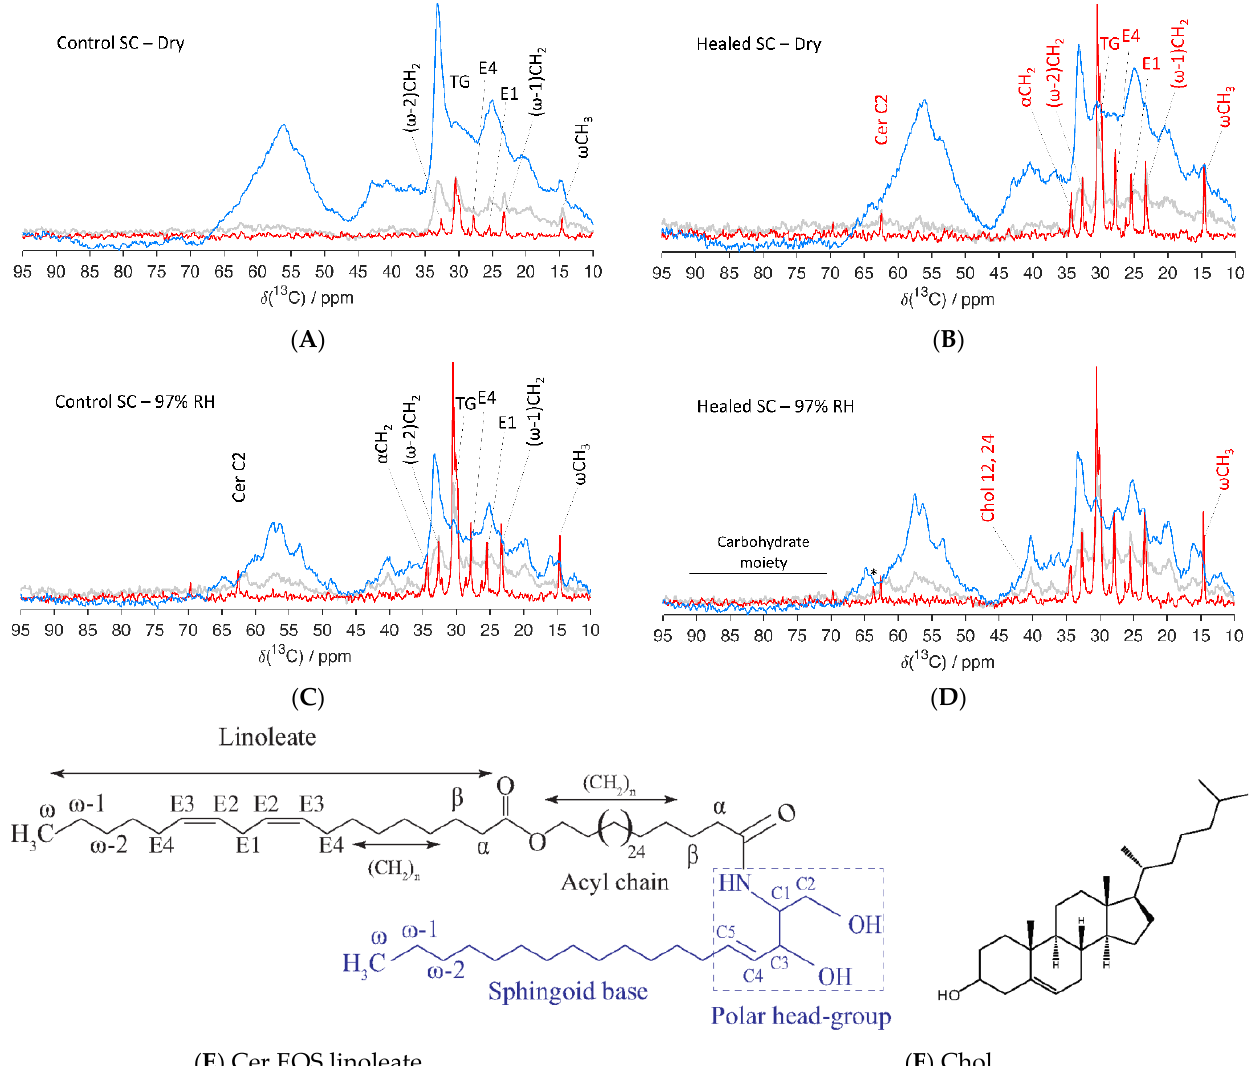
Figure 7. Natural abundance 13 C polarization transfer solid state NMR (PTssNMR) study on control ( A , C ) and healed ( B , D ) SC samples in dry ( A , B ) and wet ( C , D ) conditions. The individual direct polarization (DP) (grey), cross polarization (CP) (blue), and insensitive nuclei enhanced by polarization transfer (INEPT) (red) spectra were overlaid in all experiments for the purpose of comparison. The resonance lines originating from various SC lipid molecular segments along with Chol are labelled in the spectra. The labelling is provided in black for control and red in healed SC when changes in the INEPT signals were observed compared to control SC. The peak labeled with (*) in the healed SC at 97% RH might indicate the presence of glycosphingolipid. Assignments of various lipid molecular segments with their numberings are depicted with a representative ceramide (Cer) structure — Cer EOS linoleate ( E ), as well as for Chol ( F ).